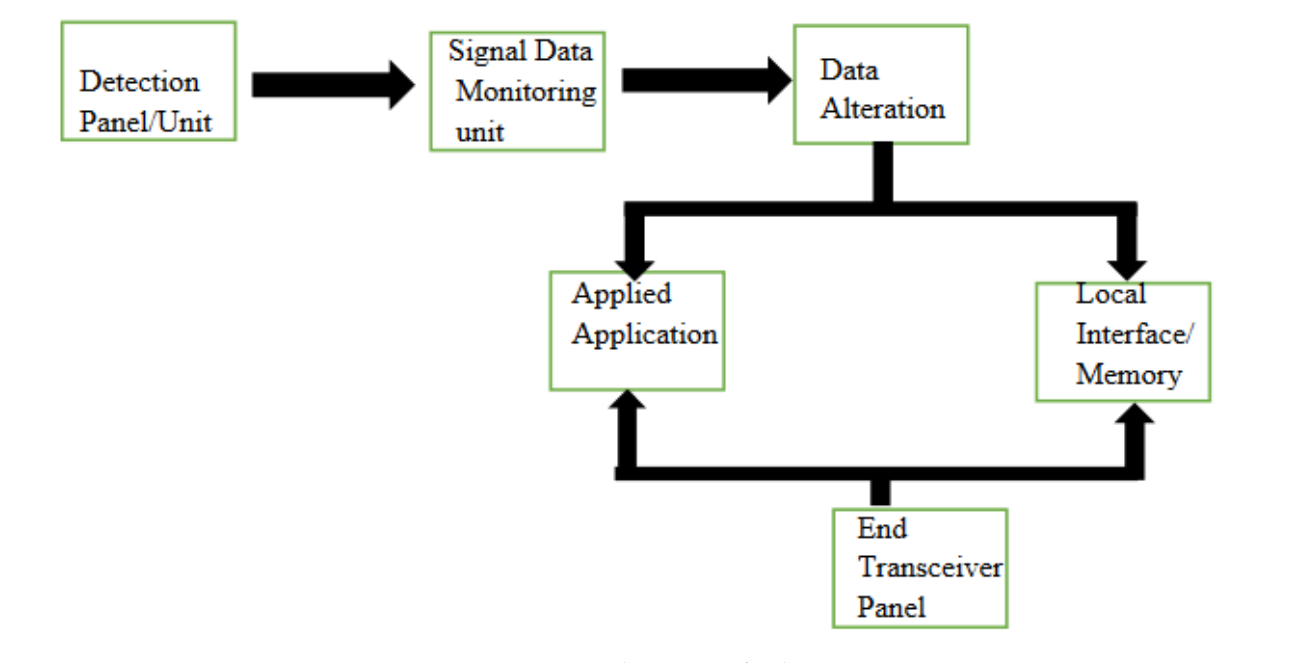
Figure 16. Sensor operation in the context of Industry 4.0.